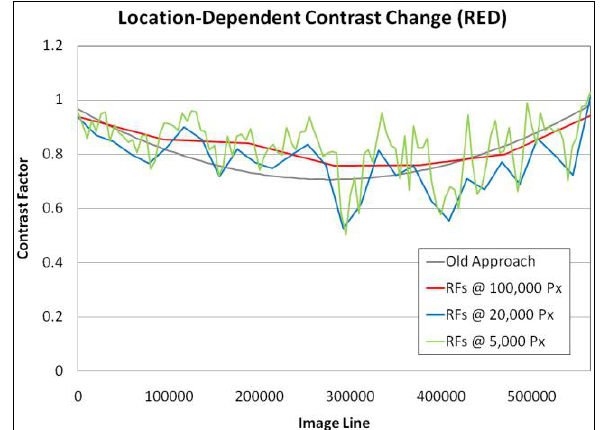
Figure 7. Contrast correction along an ADS strip (center of the overlap): ‘old’ polynomial model (Gehrke, 2010) vs. radiometry fix model with different along-strip spacing of 100,000, 20,000 and 5,000 image pixels between radiometry fixes.